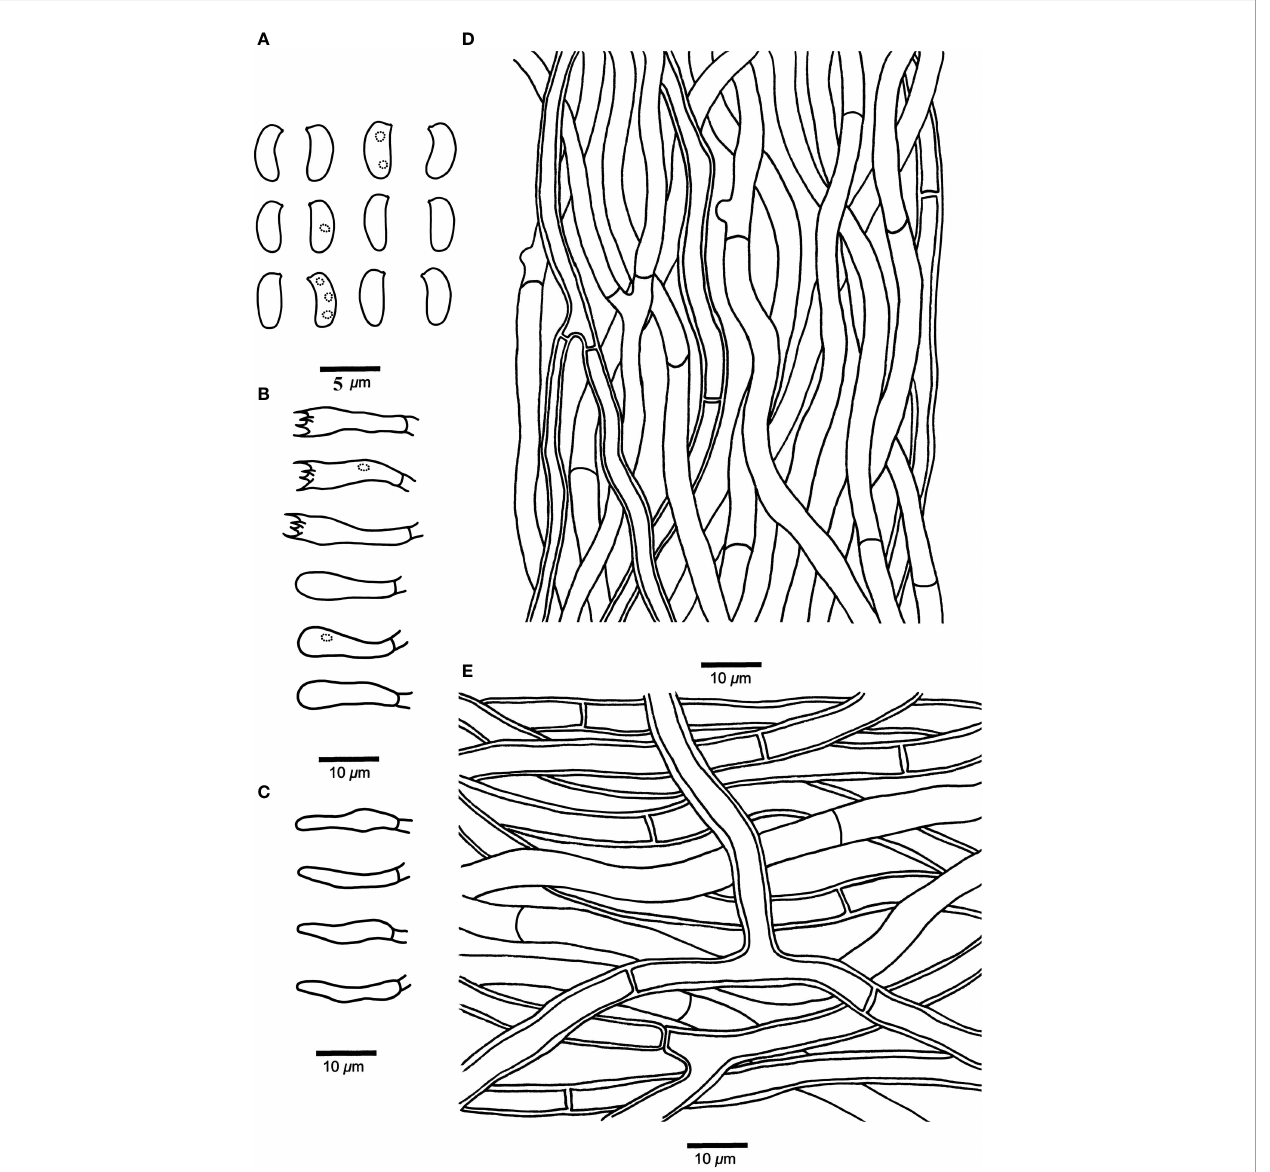
FIGURE 4 Microscopic structures of Leptoporus submollis (drawn from the holotype). (A) Basidiospores. (B) Basidia and basidioles. (C) Cystidioles. (D) Hyphae from trama. (E) Hyphae from context. Scale bar: A = 5 µm; B – E = 10 µm. Drawings by Shun